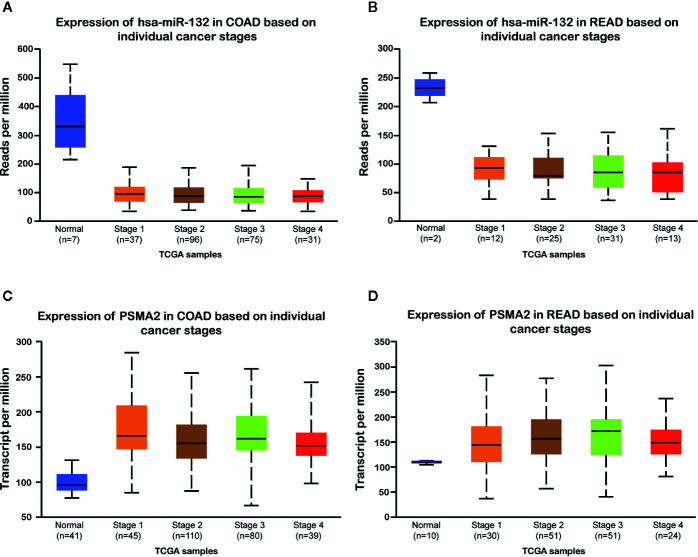
miR-132 was down-regulated and PSMA2 was up-regulated in CRC samples. (A, B) compared to normal tissues, both colon adenocarcinoma (COAD) and rectum adenocarcinoma (READ) tissues lowly expressed miR-132 levels. (C, D) PSMA2 was significantly up-regulated in both COAD and READ samples.